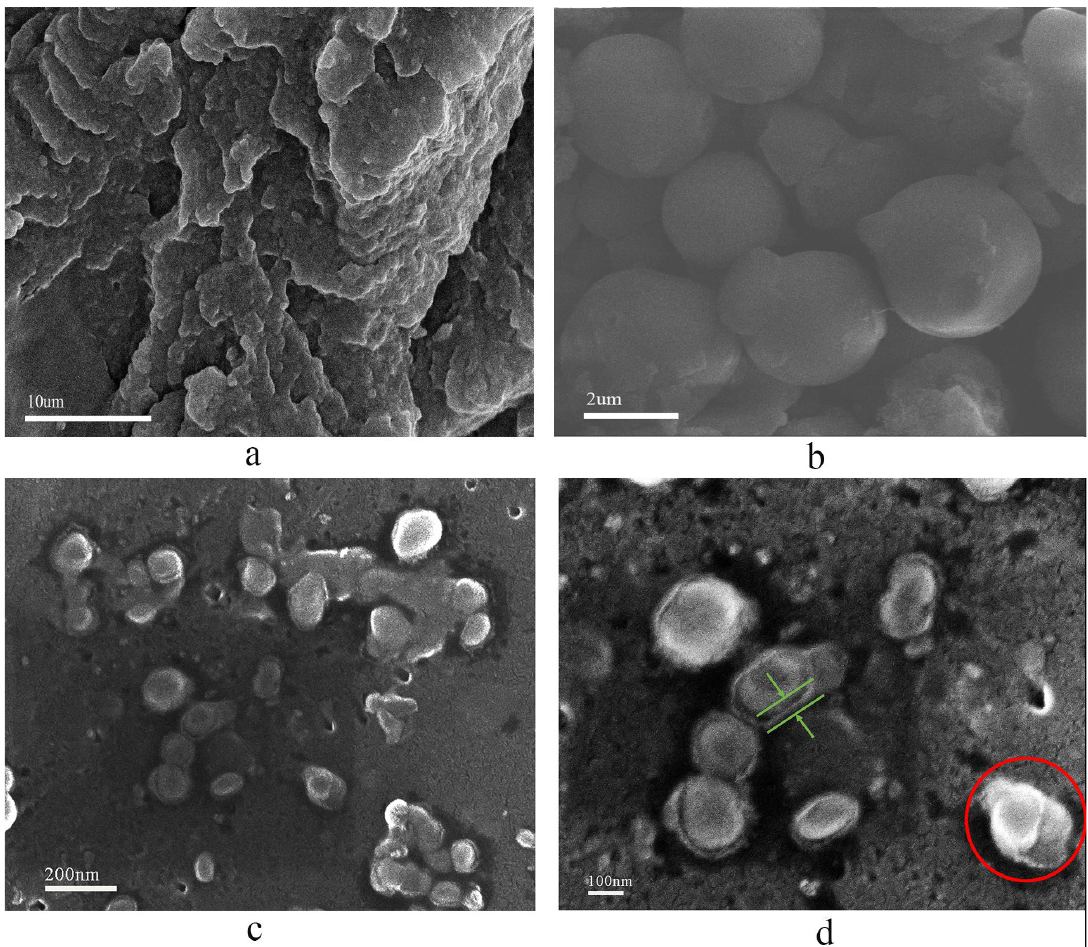
Figure 6. The microtopography of FR–PA66. ( a ) The SEM microtopography of pure PA66, ( b ) the SEM microtopography of HCNP only, and ( c , d ) the SEM microtopography of FR–PA66. And green lines and arrows and red circle: the peeling phenomenon on the surface of the microsphere.